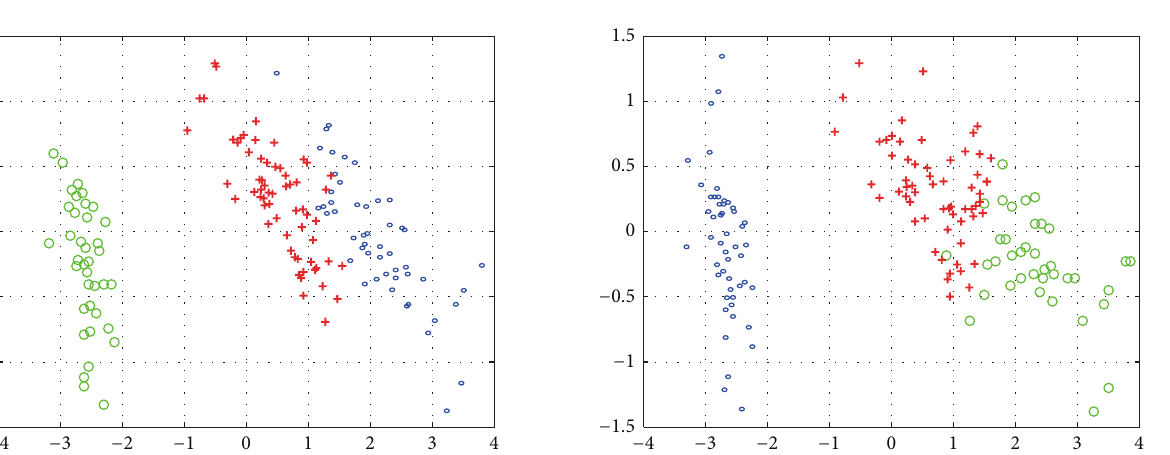
Figure 6: Clustering results of dataset by Matlab figure.